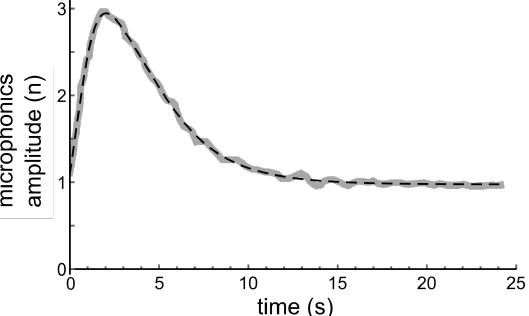
Figure 4. Thick grey line: Digitised middle part of the lower trace in Figure 2. Dashed line: Fit with Equation (2) for the relation between microphonics amplitude and hair bundle displacement, assuming an exponentially decreasing velocity for the return of the hair bundle to its resting position.